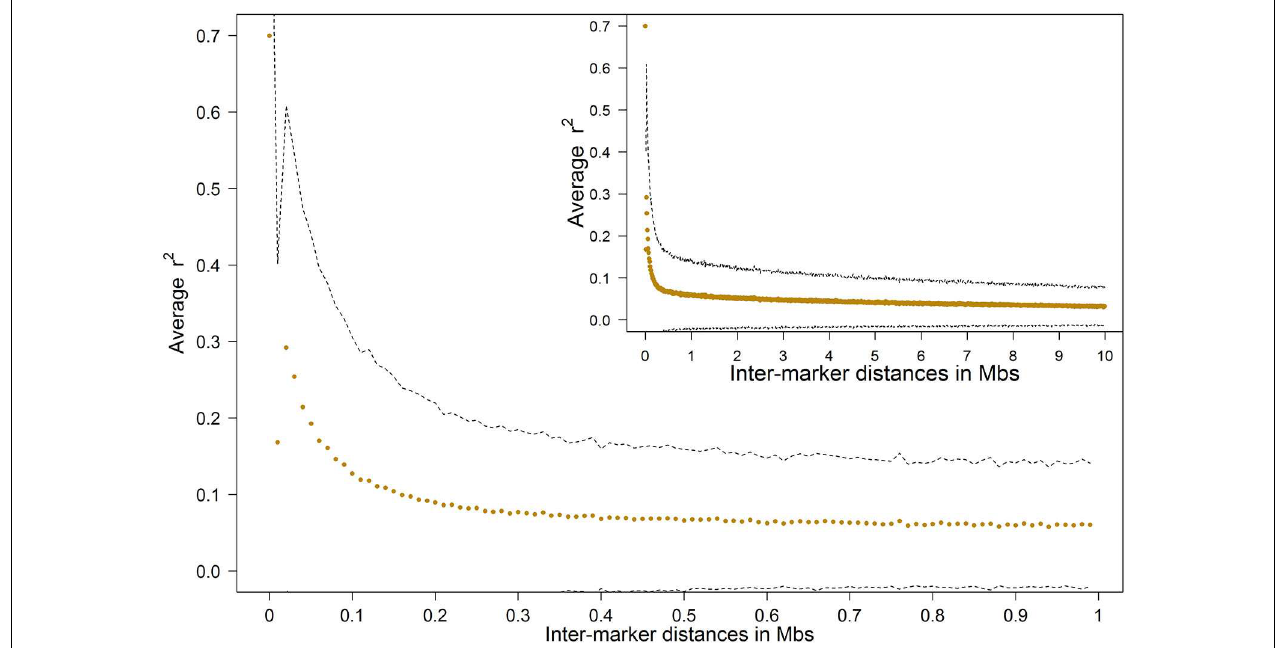
FIGURE 2 | Average LD decay in the Tyrol Grey population, dashed lines show the standard deviation boundary.